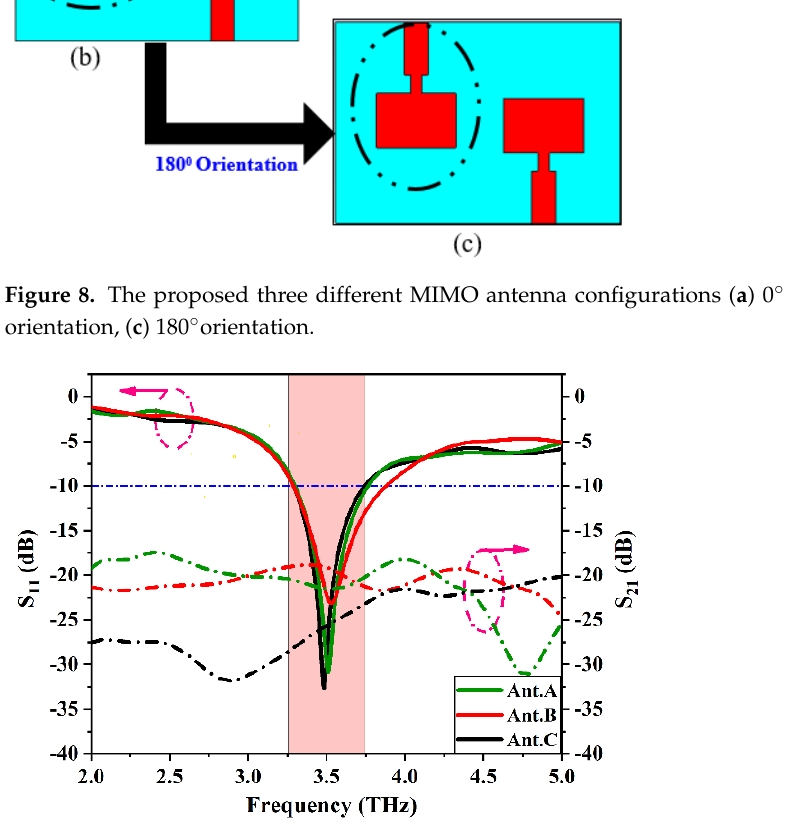
Figure 8. The proposed three different MIMO antenna configurations (a) 0° orientation, (b) 90° orientation, (c) 180°orientation.